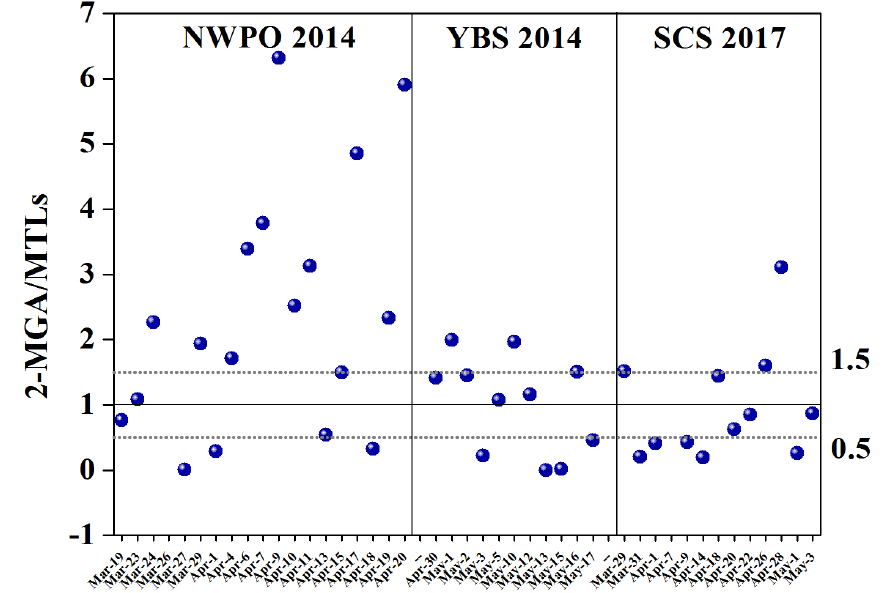
Figure 4. Spatial 2-MGA / MTLs ratio among SOA I tracers over three marine